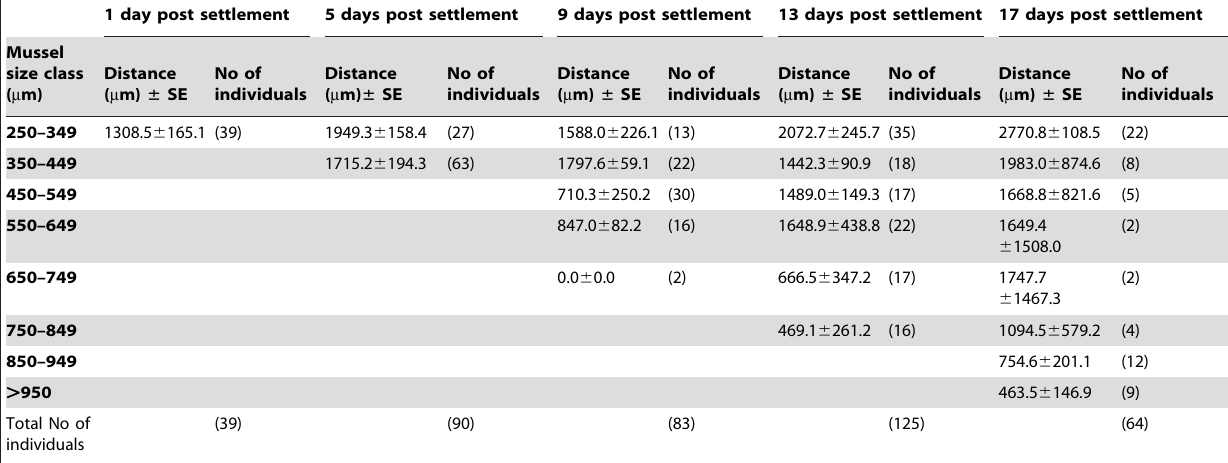
Table 1. Mean distance ( m m) of individual mussels to the exterior of ropes after 1, 5, 9, 13, and 17 days post